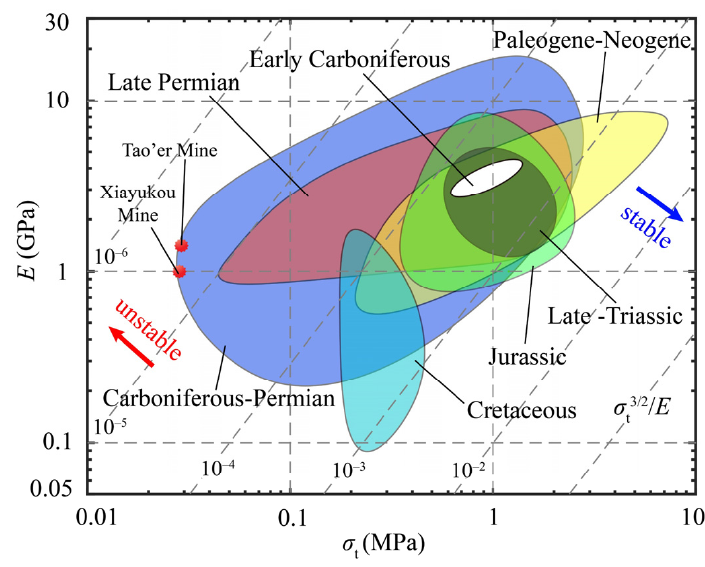
Figure 3. Stability of coals formed in different periods in China.